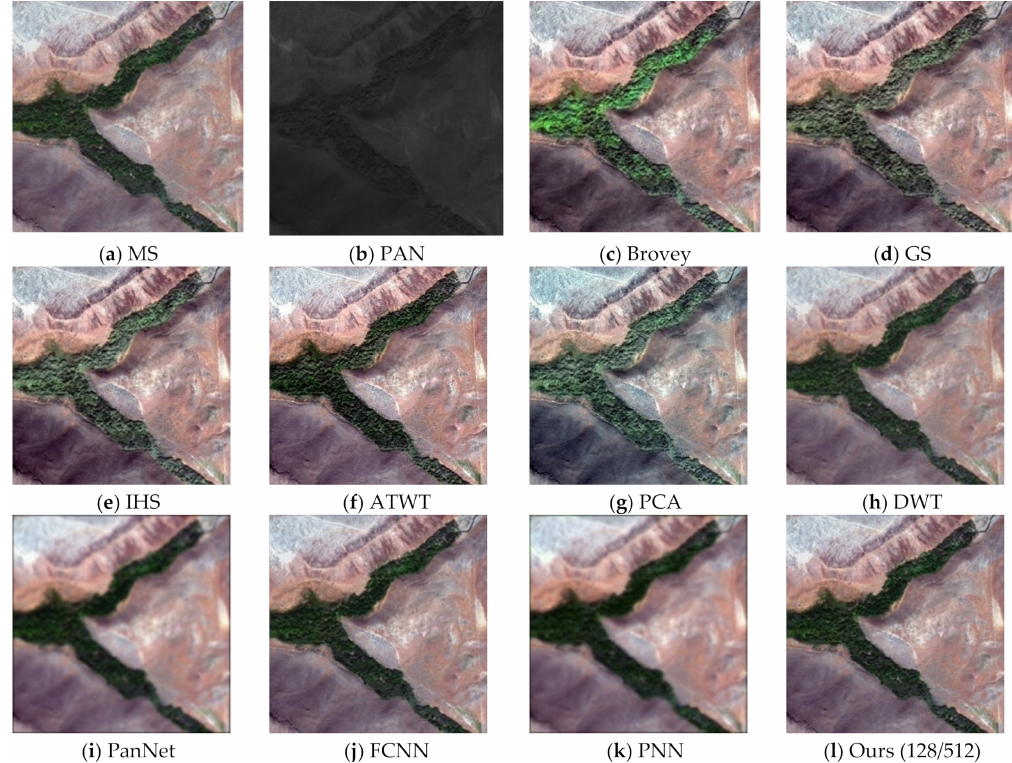
Figure 11. Fusion results for the second group of remote sensing image